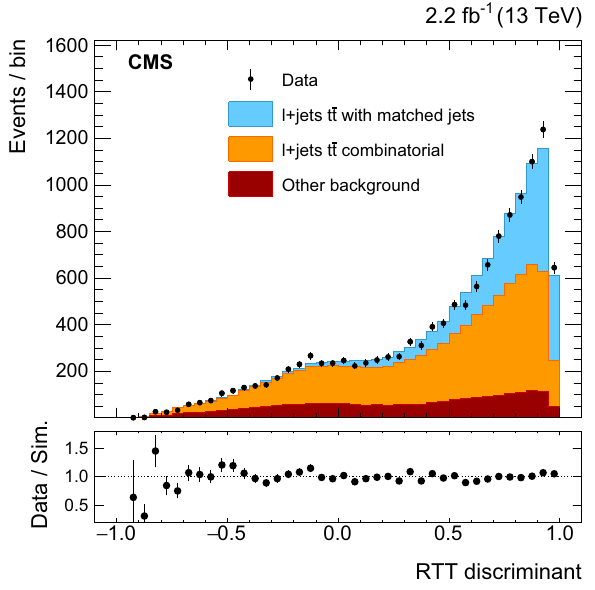
Fig. 2 The distribution of the RTT discriminant in data enriched in (cid:5) + jets tt events. Simulated (cid:5) + jets tt events in which jets from the all-hadronic top quark decay are correctly chosen are labeled “ t t ( 1 (cid:5)) with matched jets”. Simulated (cid:5) + jets tt events in which an incorrect combinationofjetsischosenarelabeled“ tt ( 1 (cid:5)) combinatorial”.Events from processes that do not contain a hadronically-decaying top quark, such as dileptonic t t , are labeled “other background”. The uncertainties shown in the ratios of data to simulation are statistical only. Jet triplets search are considered to be top quark in the all-hadronic t t + p miss T tagged if their RTT discriminant value is larger than